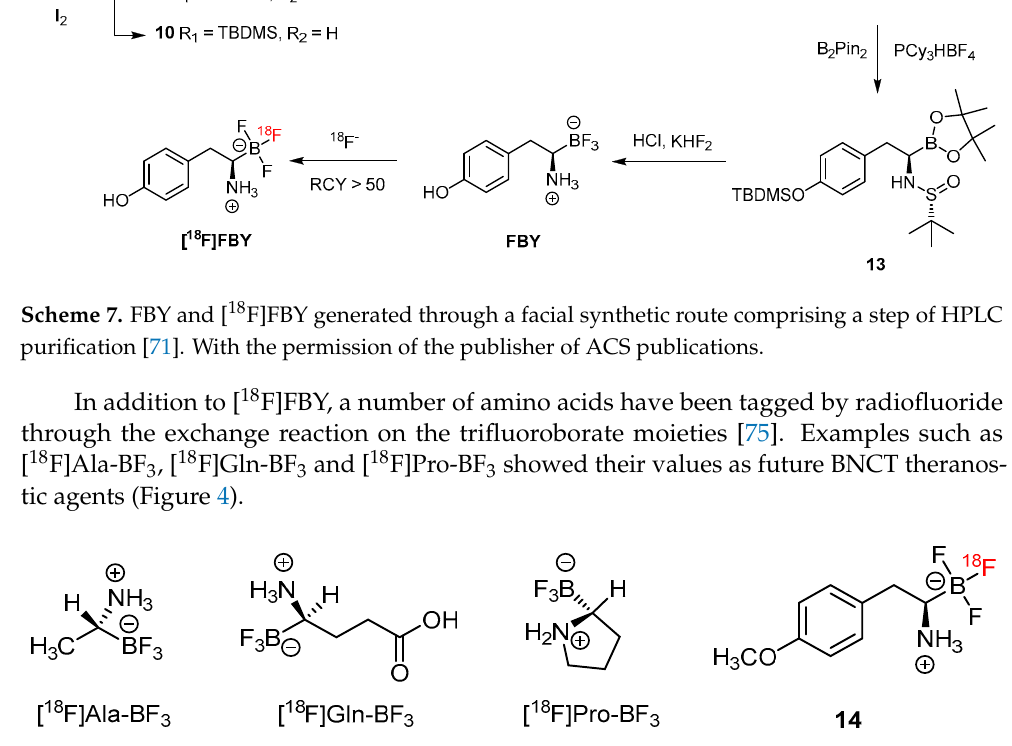
Figure 4. Radiofluoride-exchanging trifluoroborate-substituted amino acid analogs for tumor imag- Figure 4. ing [75].